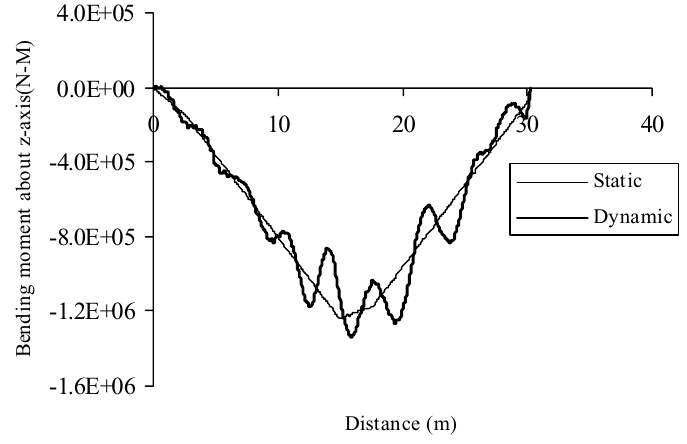
Fig. 10. Time histories for bending moment about transverse axis.